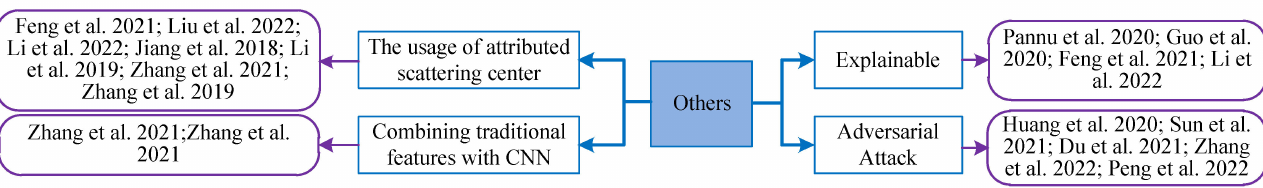
Figure 25. The other directions in SAR ATR